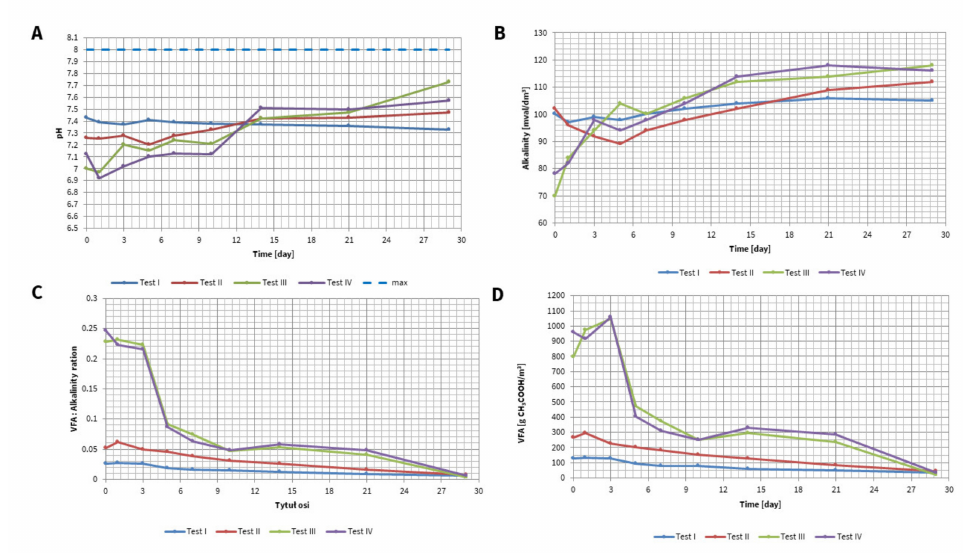
Figure 6. Changes in the value of: ( A ) pH; ( B ) alkalinity; ( C ) VFA: alkalinity; ( D ) VFAs for the analyzed